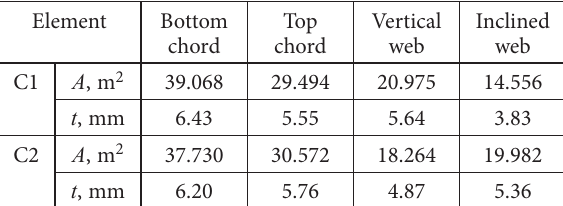
Table 1. Optimization results